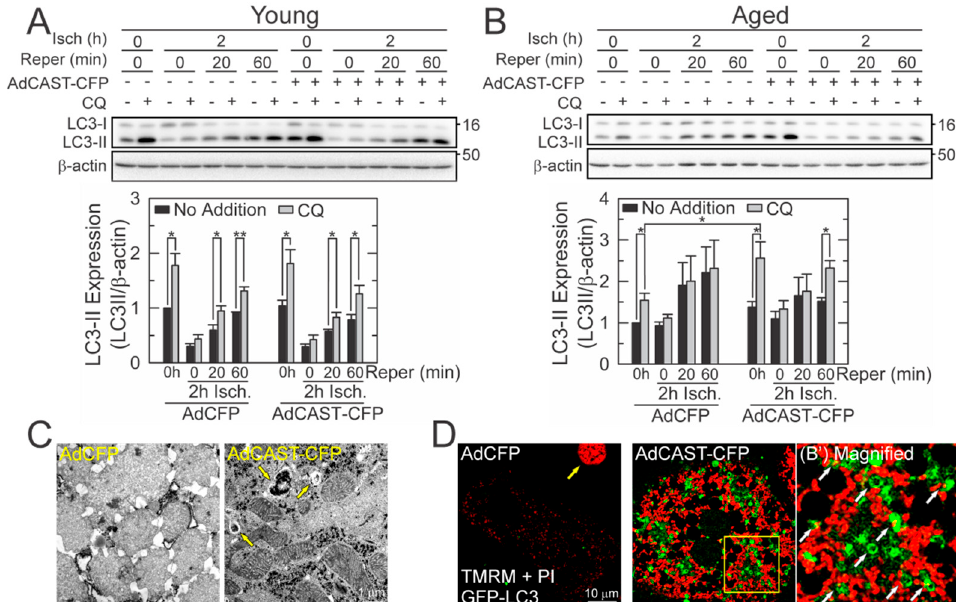
Figure 4. Restoration of autophagic flux in reperfused aged hepatocytes by CAST overexpression. Autophagic flux after 2 h of ischemia in young ( A ) and aged ( B ) hepatocytes with and without CAST overexpression ( n = 5). Autophagic flux was measured by IB of LC3-II levels in the presence or absence of 20 µ M CQ. Graph represents the quantification of LC3-II relative to its level at normoxia without CQ. ( C ) TEM images in reperfused aged hepatocytes with and without CAST overexpression. Yellow arrows indicate autophagic vehicles. ( D ) Representative confocal images of GFP-LC3 and TMRM after 2 h of ischemia followed by 30 min of reperfusion in aged hepatocytes. Yellow and white arrows indicate cell death and the onset of mitophagy, respectively. The right panel is an enlarged image of the square yellow inset in the middle panel. * p < 0.05 and ** p < 0.01.